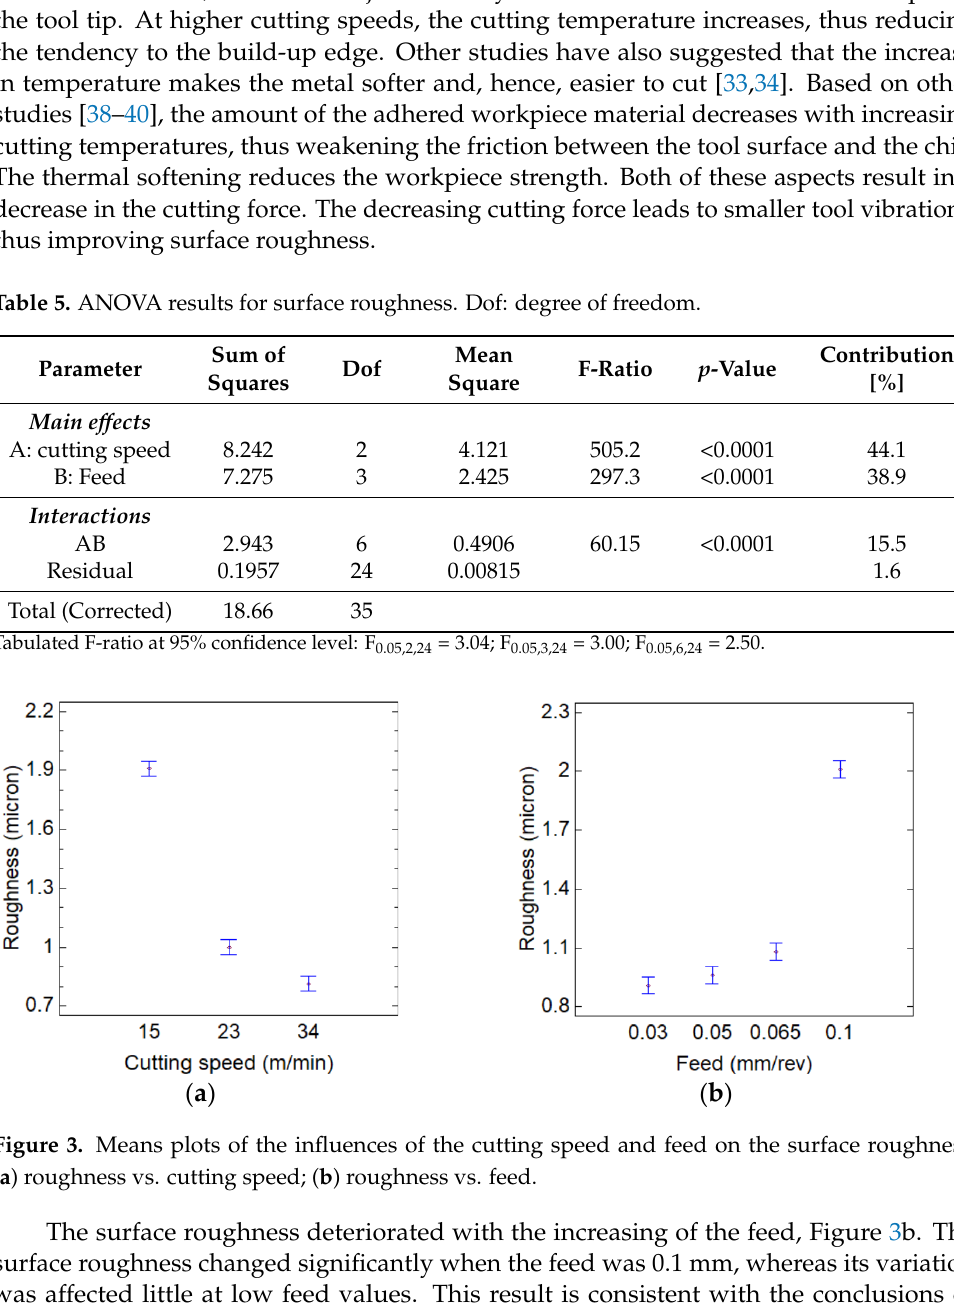
Figure 4. Interaction plot of the combined influence of the cutting speed and feed on the surface roughness. The response surface model was used to determine how changes in variables affect the response of interest. A two-order response surface regression equation in uncoded units, which interprets the coefficients using the natural units of each variable, was used to relate the surface roughness of the machined parts to the cutting parameters, as follows: Ra (μm) = 3.551 − 0.2274 v + 8.49 f + 0.005097 v 2 + 295.5 f 2 − 1.305 v f (1) where v is the cutting speed (m/min) and f the feed (mm/rev). The coefficient of determi- nation (R-squared), which is a statistical measure of how close the data are to the fitted regression line, was 96.2%. This equation was only valid within the process parameter ranges of Table 3; outside this range, the corresponding results were not supported by experimental data. The corresponding contour plot is shown in Figure 5 to point out the dependency of the surface roughness on cutting speed and feed. The graph confirms that better roughness values could be obtained with intermediate feed, while larger cutting speeds were required at increasing feed values. This result is consistent with previous studies on the dry machining of titanium alloys. According to Sun et al. [38], the tool nose curvature did not participate completely in cutting for a low feed rate of 0.05 mm/rev. Thus, the surface roughness initially decreased from about 1.1 to 0.9 μm (cutting speed of 60 m/min and cutting depth of 1 mm) with the feed rate increasing from 0.05 to 0.065 mm/rev. For higher feed, the high tool wear was considered to be the main cause for higher roughness values, with a roughness of about 1.4 μm at 0.1 mm/rev. Similar results have also been found in [42,43].